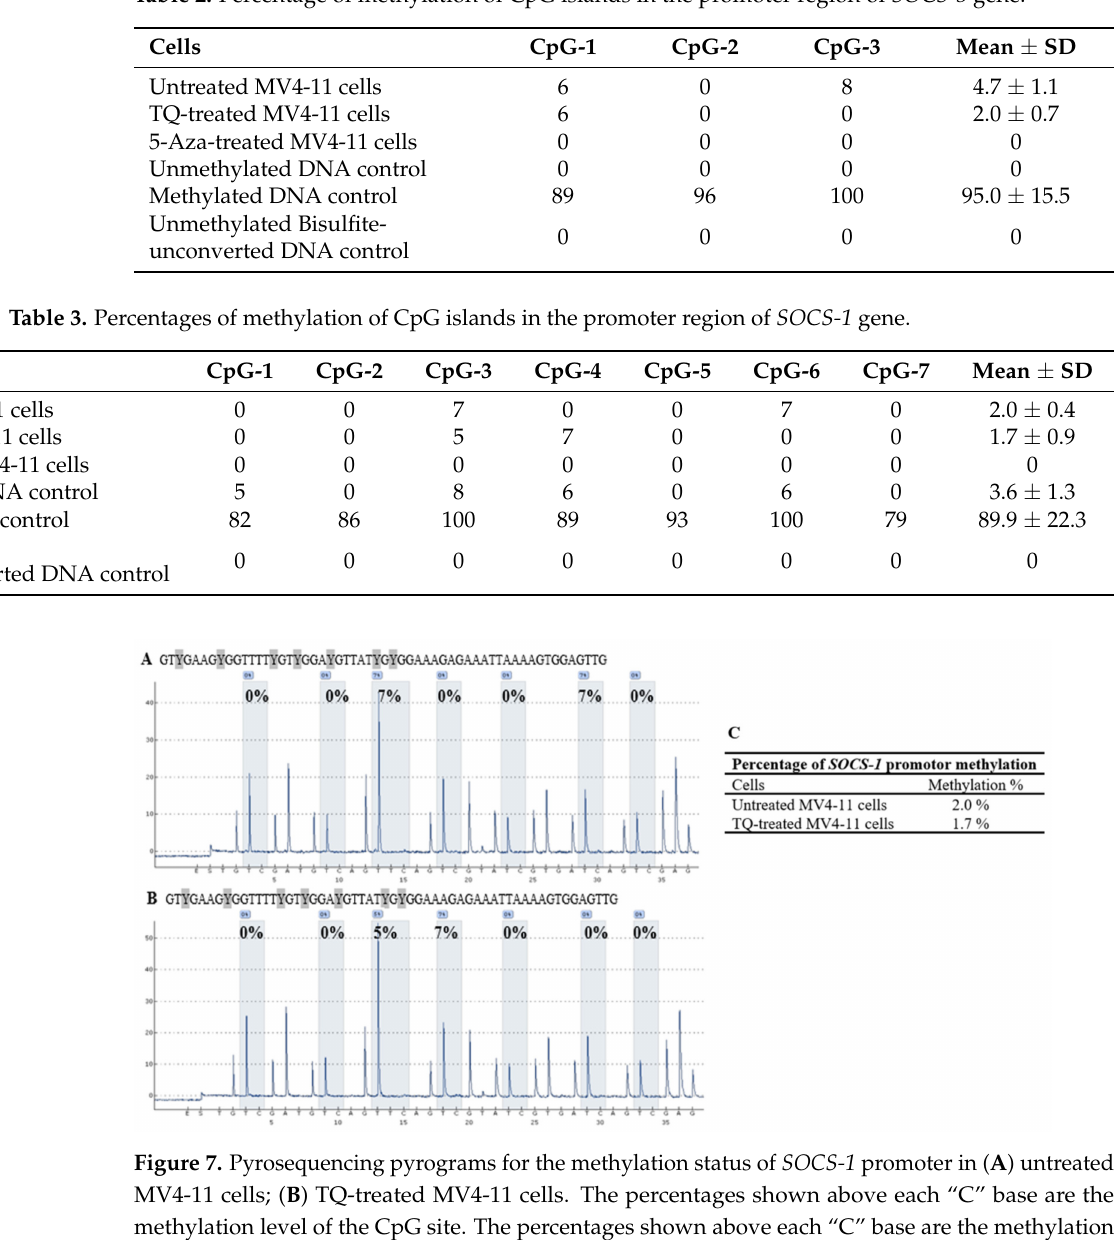
Table 2. Percentage of methylation of CpG islands in the promoter region of SOCS-3 gene.